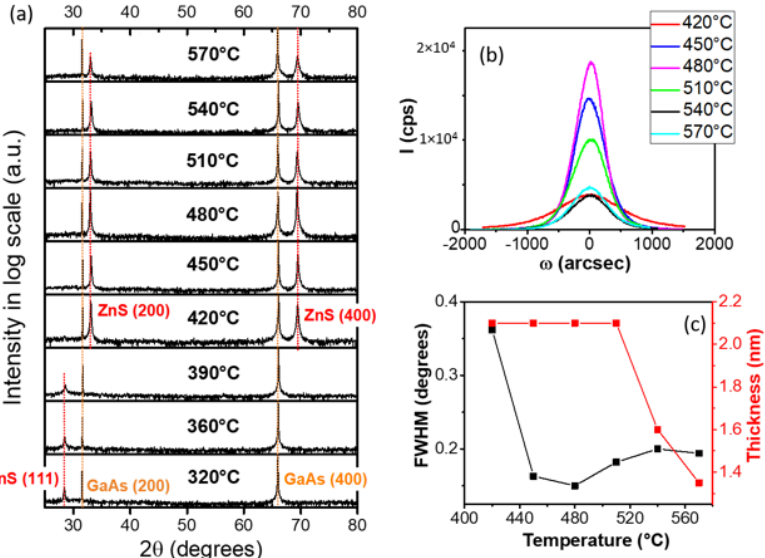
Figure 2. X-ray diffraction analysis of ZnS layers grown at various temperatures, from 320 ◦ C Figure 2. X ‐ ray diffraction analysis of ZnS layers grown at various temperatures, from 320 °C to 570 to 570 ◦ C: ( a ) θ -2 θ scans, ( b ) ω -2 θ rocking curves, and ( c ) full width at half-maximum and layer °C: ( a ) θ‐ 2 θ scans, ( b ) ω‐ 2 θ rocking curves, and ( c ) full width at half ‐ maximum and layer thickness thickness plots, as a function of the growth plots, as a function of the growth temperature.